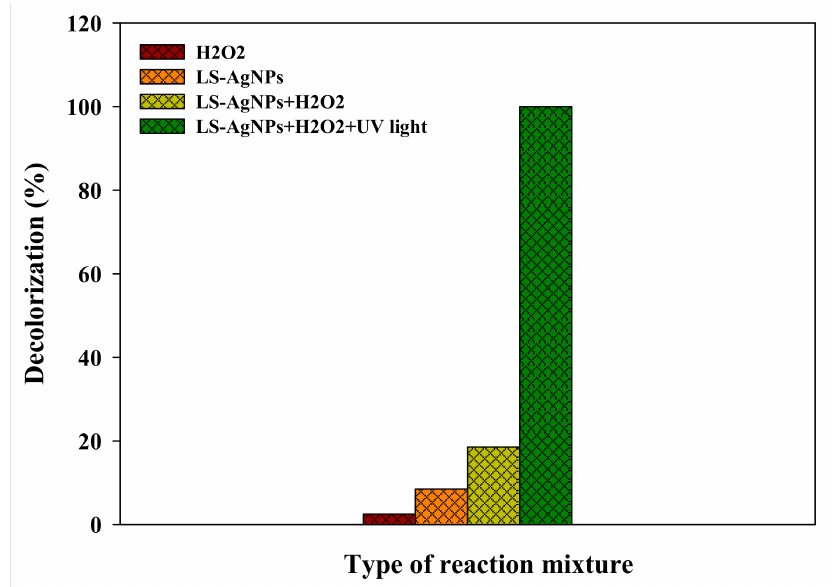
Figure 6. The effect of the redox mediator and UV-light irradiation on the photocatalytic degradation of Reactive Yellow 4G by LS–Ag